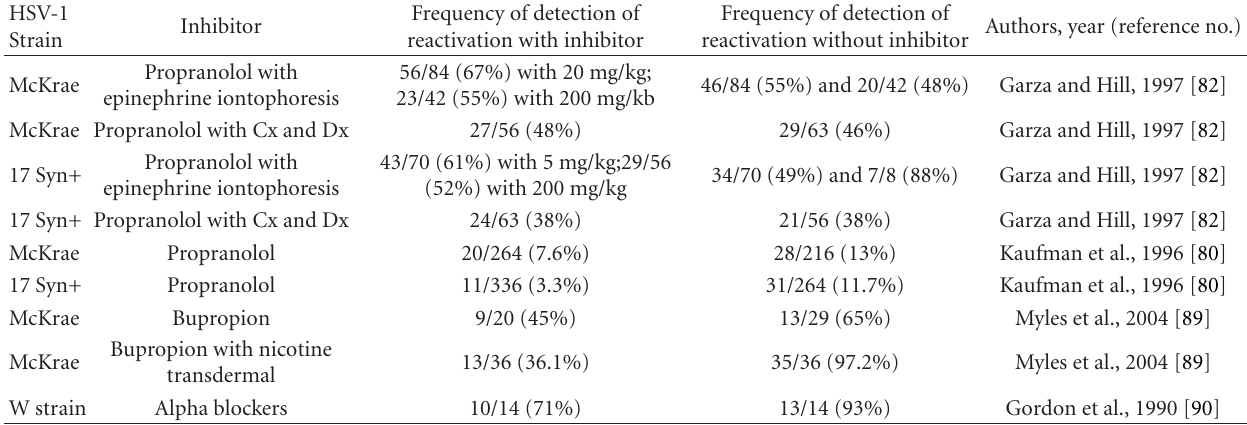
Table 7: Inhibitor of HSV-1 reactivation in latently infected rabbits.